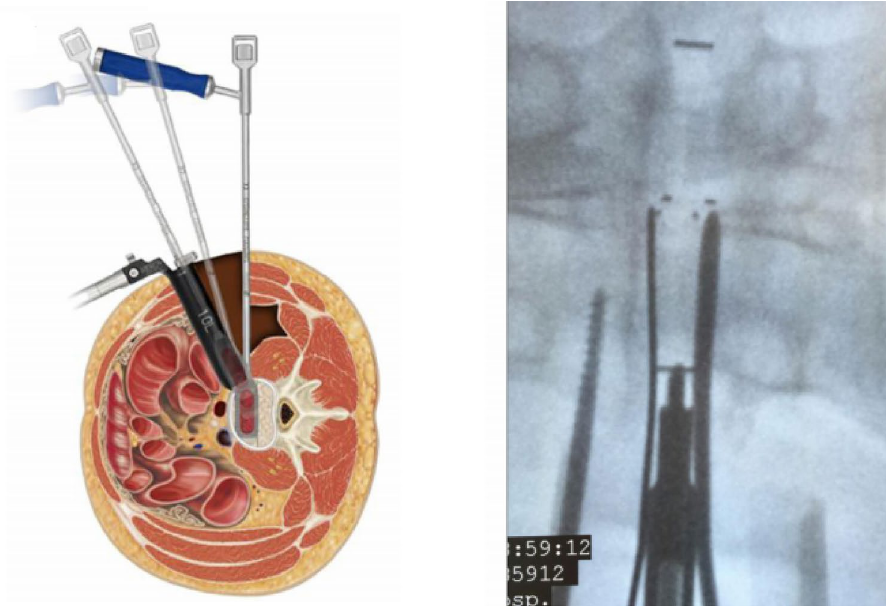
Figure 1. When inserting the cage, the inserter enters it obliquely and then turns it orthogonally to allow the surgeon to place the cage orthogonally across the disc